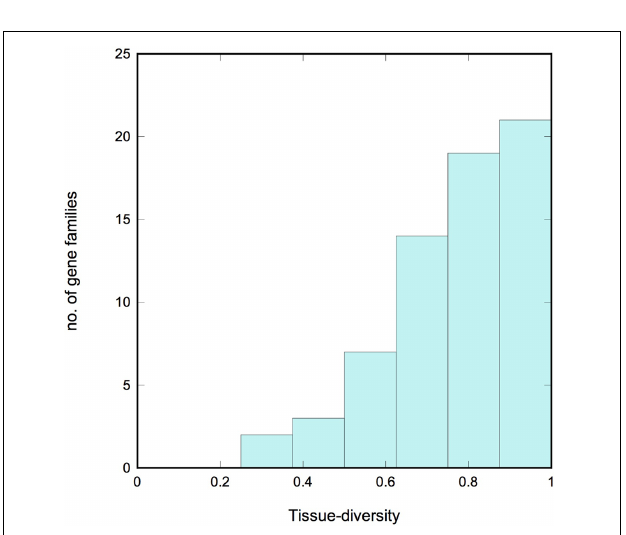
FIGURE 4 | Tissue diversity. Histogram showing the tissue diversity of the gradient gene families. A value of 0 corresponds to a gene family whose expression is limited to a single tissue (“specialized”), while a value of 1 corresponds to a family whose members are expressed with equal frequency across all 10 tissues examined (“diverse”). Note the strong bias toward